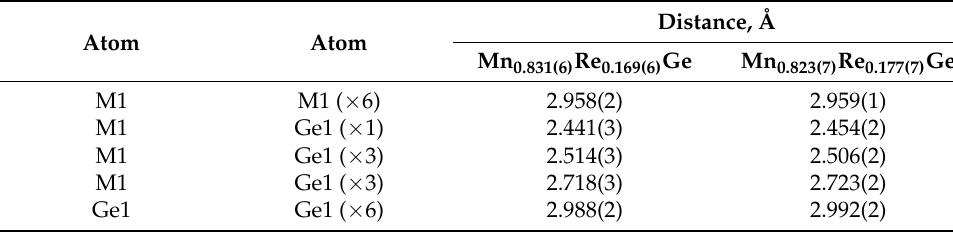
Table 3. Selected interatomic distances in Mn 1 − x Re x